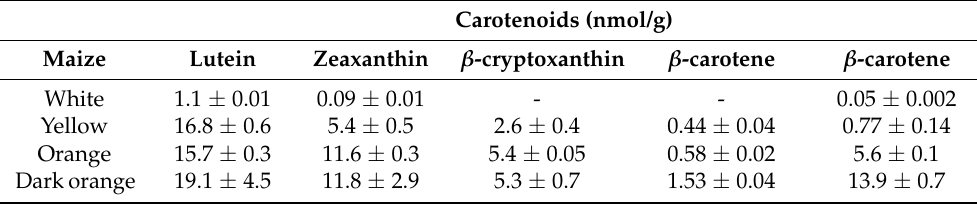
Table 2. Carotenoid concentrations for different maize varieties (white, yellow, orange and dark